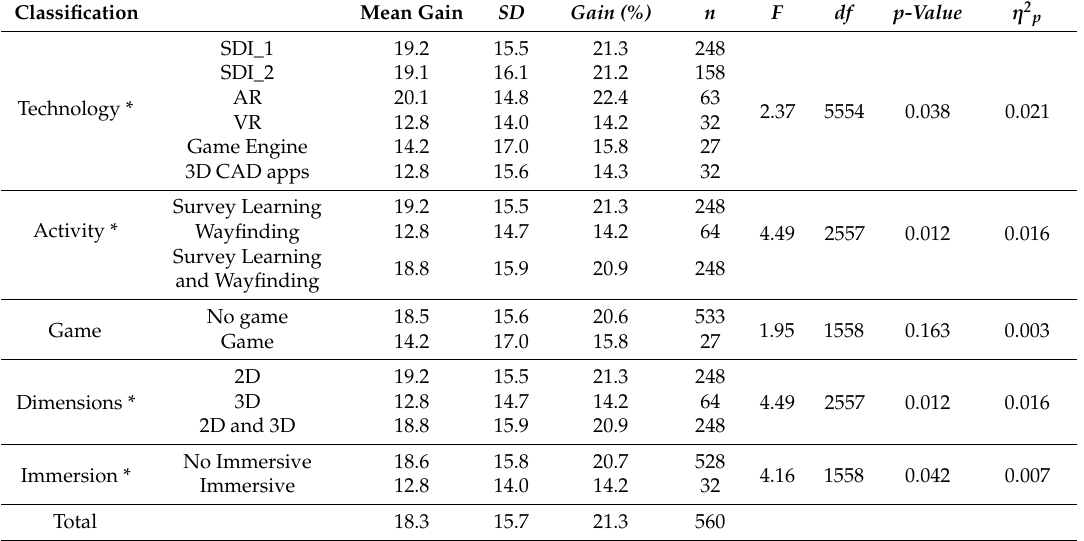
Table 2. Statistics of gains according to